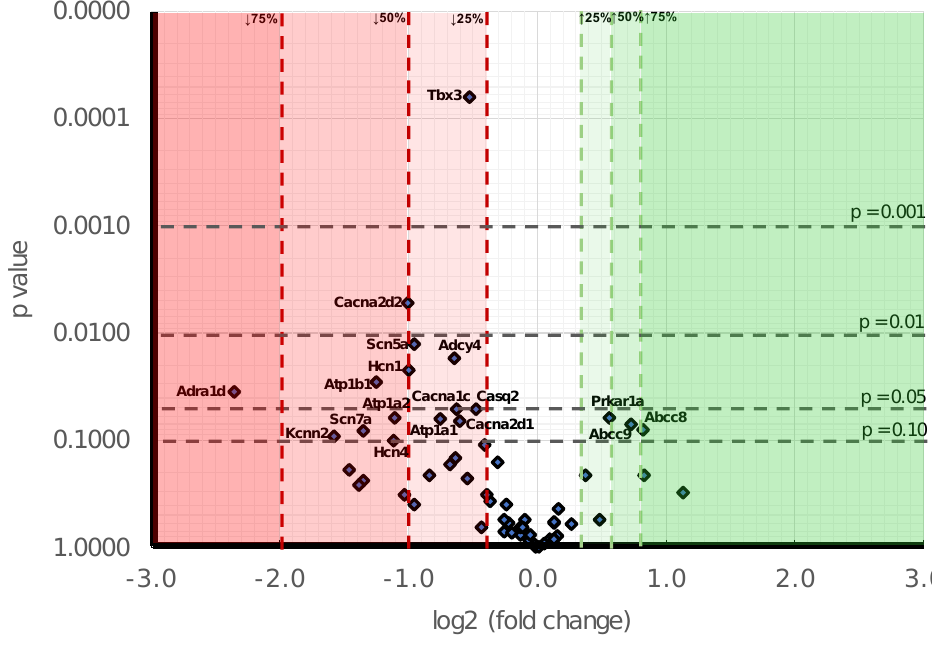
Figure 1. Volcano plot comparing stratified statistical significances in expression levels and mean gene-fold changes in Pgc-1 α − / − compared to WT atria for the collection of genes surveyed here. Horizontal stratifications correspond to probability levels p < 0.001, 0.001 < p < 0.01, 0.01 < p < 0.05 and 0.05 < p < 0.1 respectively. Ordinates stratify effect sizes indicating decreases/increases of 25%, 50%, 75% respectively. Points falling within this stratification are labelled with the gene.